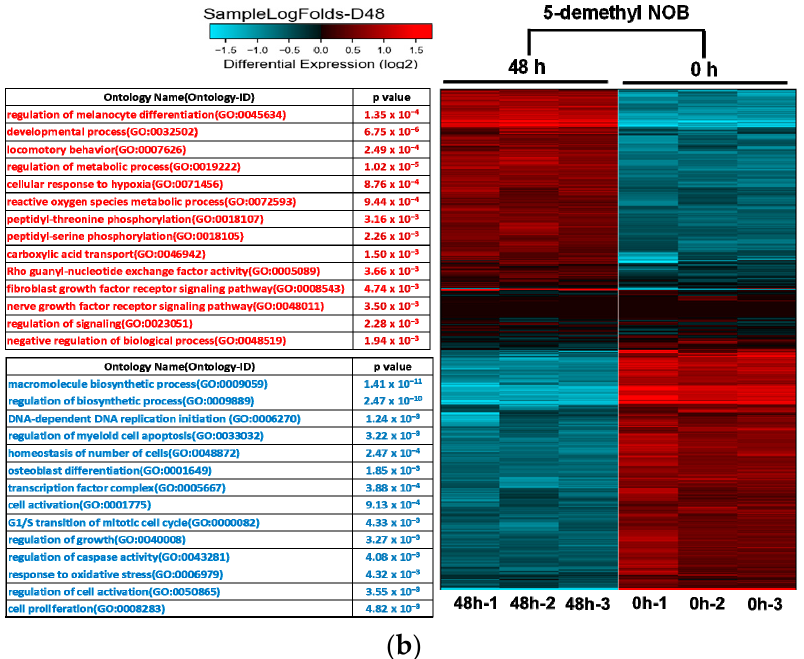
Figure 5. Enrichment analysis and visualization of Gene Ontology (GO) results for DEGs in response to 5-demethyl NOB treatment. ( a ) Significantly enriched GO biological processes (BPs) in THP-1 cells treated with vehicle vs. 5-demethyl NOB (40 µ M) were analyzed by REVIGO. The scatterplot represents functional clusters. The bubble color and size represent the p values and the frequency of the GO BP in the database, respectively. ( b ) Heatmap of enriched GO BP terms in response to 5-demethyl NOB (40 µ M) treatment. GO processes listed in the upper and lower panels are terms of upregulated and downregulated DEGs, respectively. Only some of the significantly representative GO terms are shown.